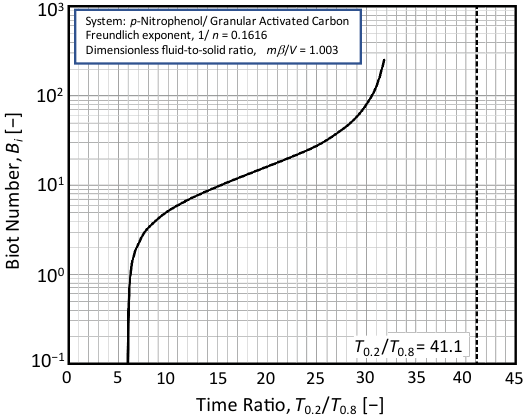
Figure 7. Determination of experimental Biot number.